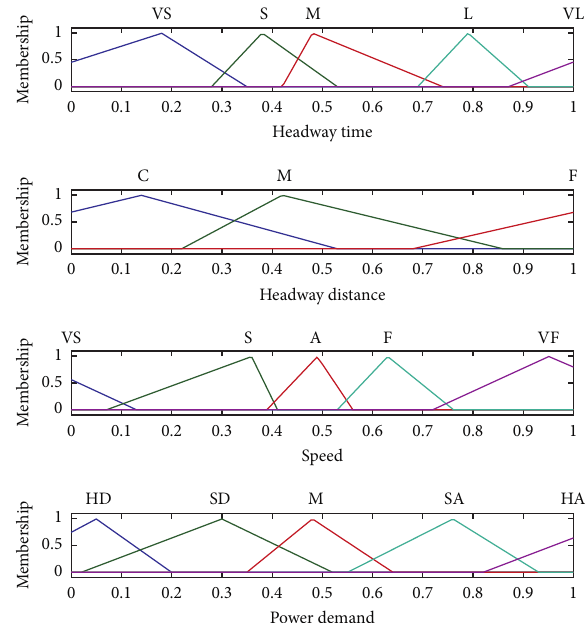
Figure 4: Calibrated membership